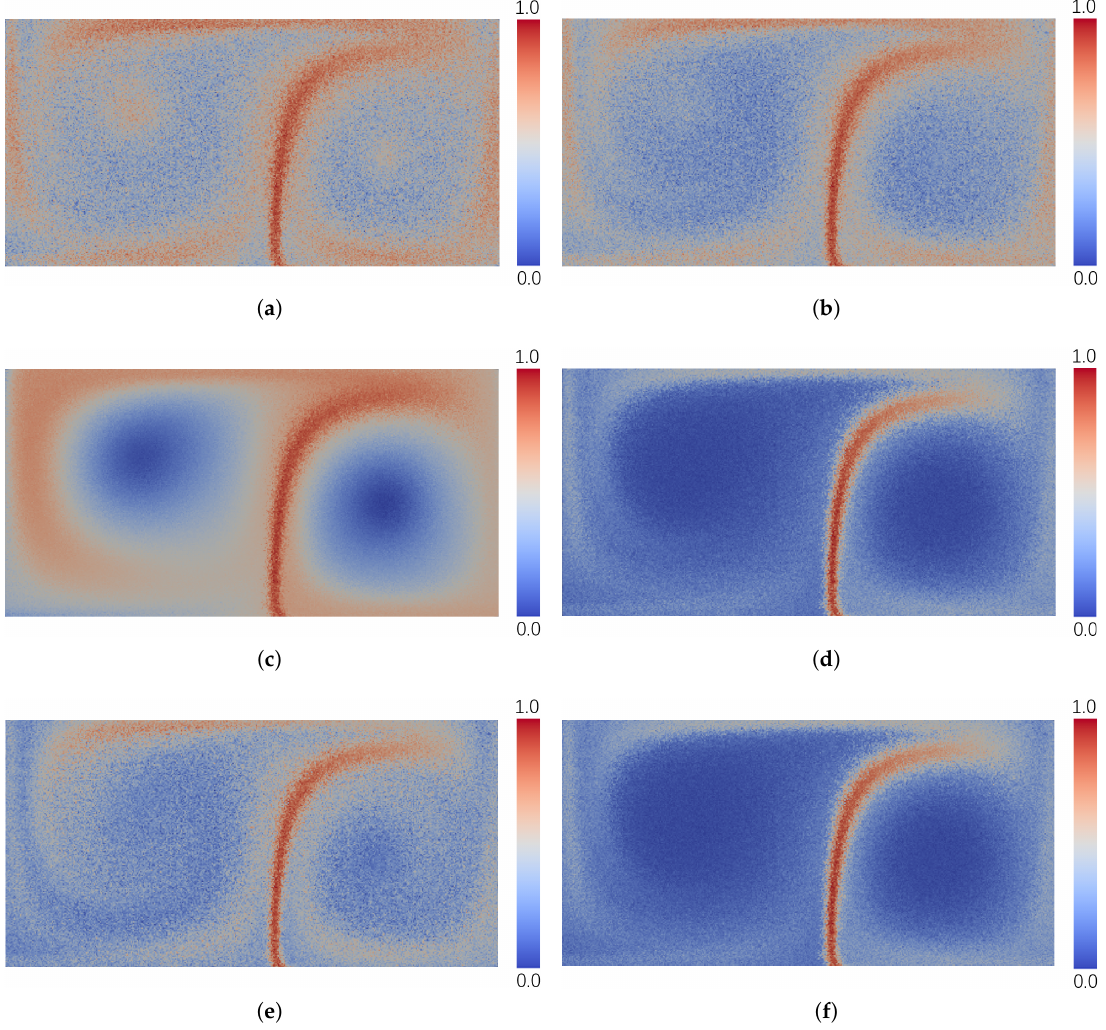
Figure 2. Results of different metrics: ( a ) Result of AEDR, ( b ) result of classical EDR, ( c ) result of Euclidean distance, ( d ) result of DTW, ( e ) result of LCSS, and ( f ) result of